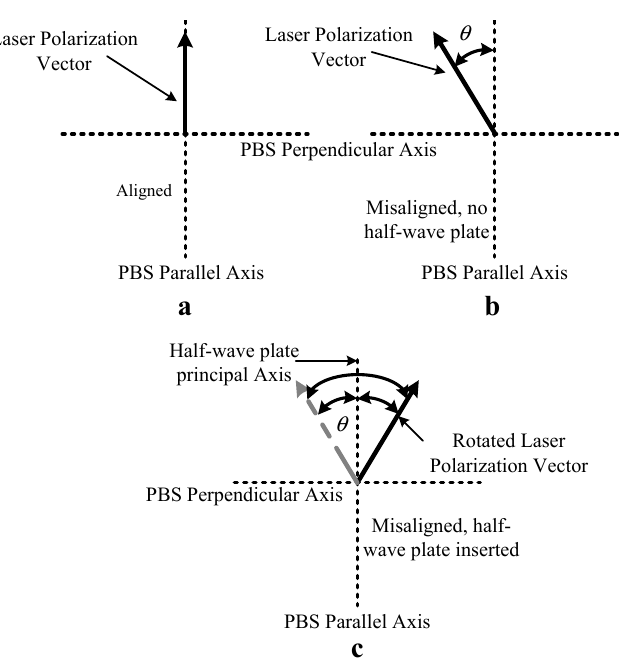
Figure 2. Receiver geometries: ( a ) a well aligned configuration; ( b ) the position of the laser polarization vector with an offset angle of θ in a receiver without half-wave plate; and ( c ) the position of the laser polarization vector with an offset angle of θ in a receiver with a half-wave plate. (Reproduction from [34]).